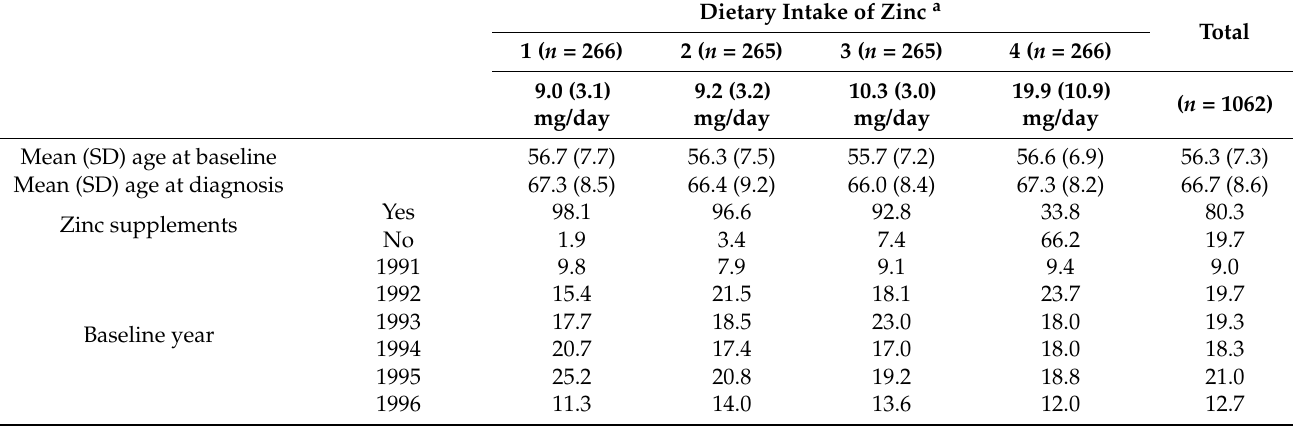
Table 2. Prognostic factors for breast cancer and zinc